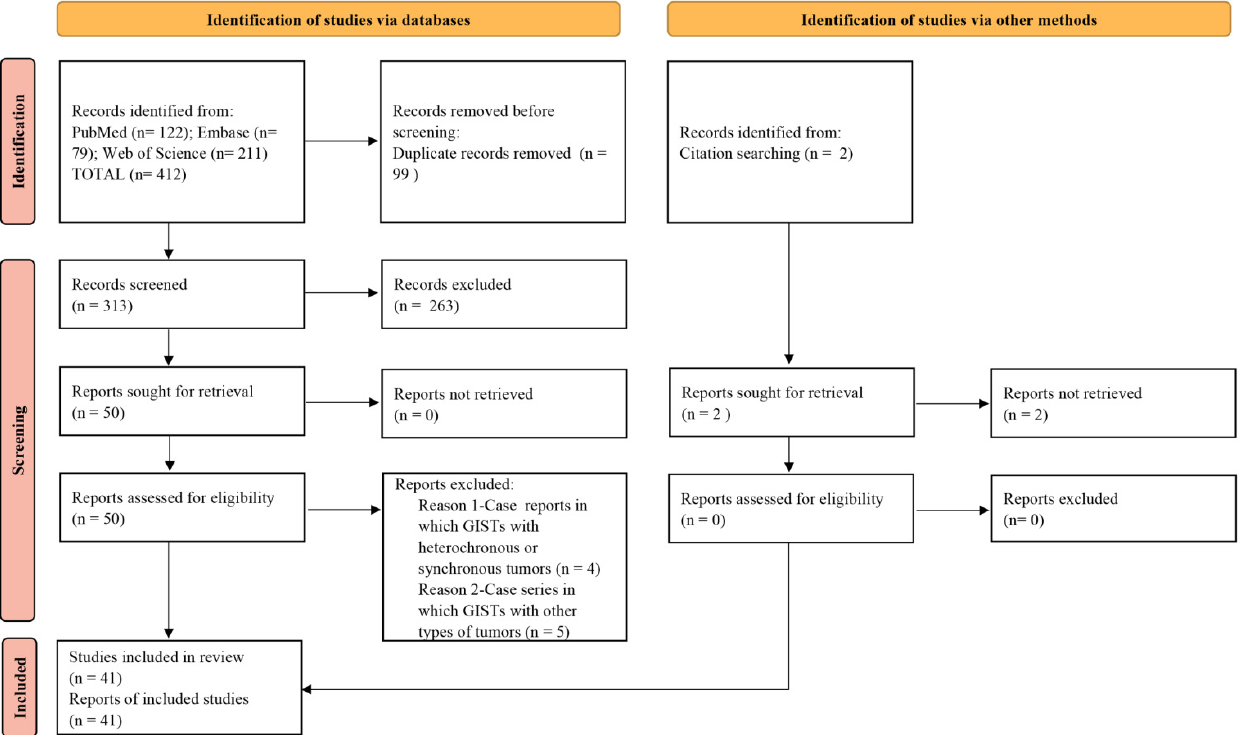
Figure 1. Flow diagram of the literature search and selection criteria.